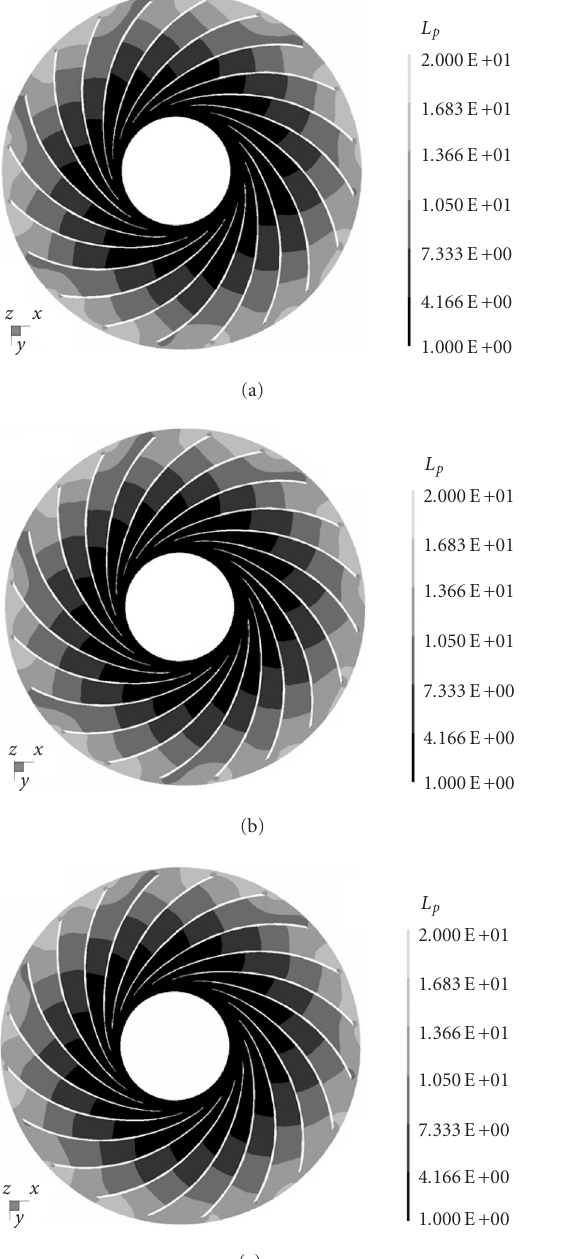
Figure 14: Static pressure distribution on impeller center plane in the vaned case at near-surge conditions: (a) starting position, (b) 1 / 3 revolution, and (c) 2 / 3 revolution.